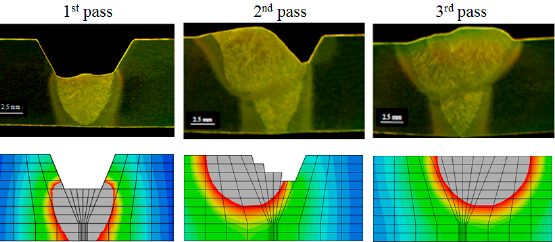
Figure 11. Comparison of simulated weld profile HAZ with macro-section analysis of butt-joint .